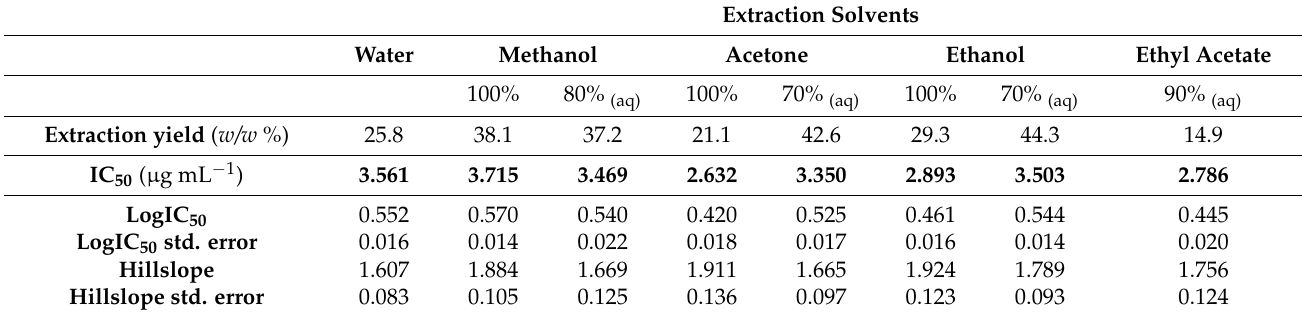
Table 1. The extraction yields and the calculated values of the half maximal inhibitory concentrations (IC 50 ) of antioxidant activity (GraphPad Prism 7 [60]) of extracts prepared with different solvents or solvent mixtures tested in the concentration range of 0.195–400 µ g mL − 1